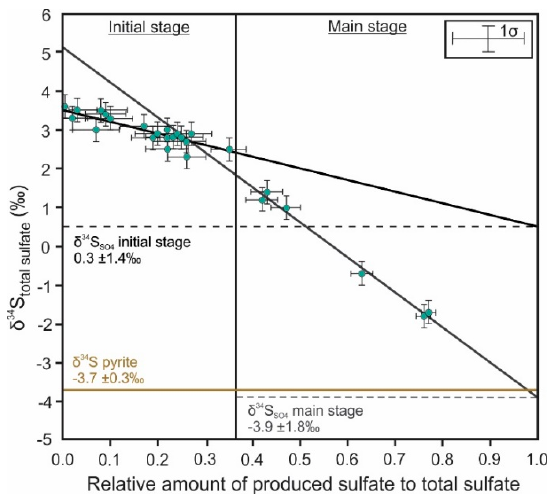
Figure 1. δ 34 S variations of sulfates as a function of their increasing amount during the initial and main stages of pyrite leaching. The dashed lines show the δ 34 S values of sulfate that are produced in the initial and the main stages. The vertical line demonstrates the transition from the initial to the main stage of pyrite leaching. Redrawn from Brunner et al. [78].